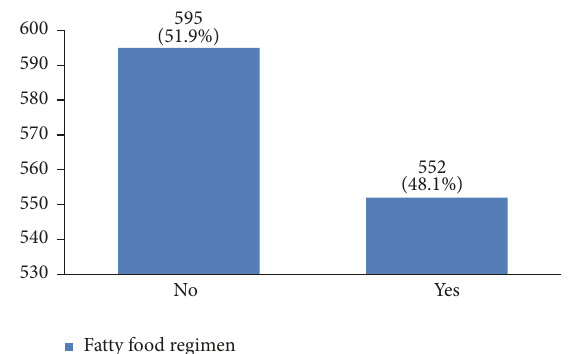
Figure 12: The fatty food regimen of the studied breast cancer cases.